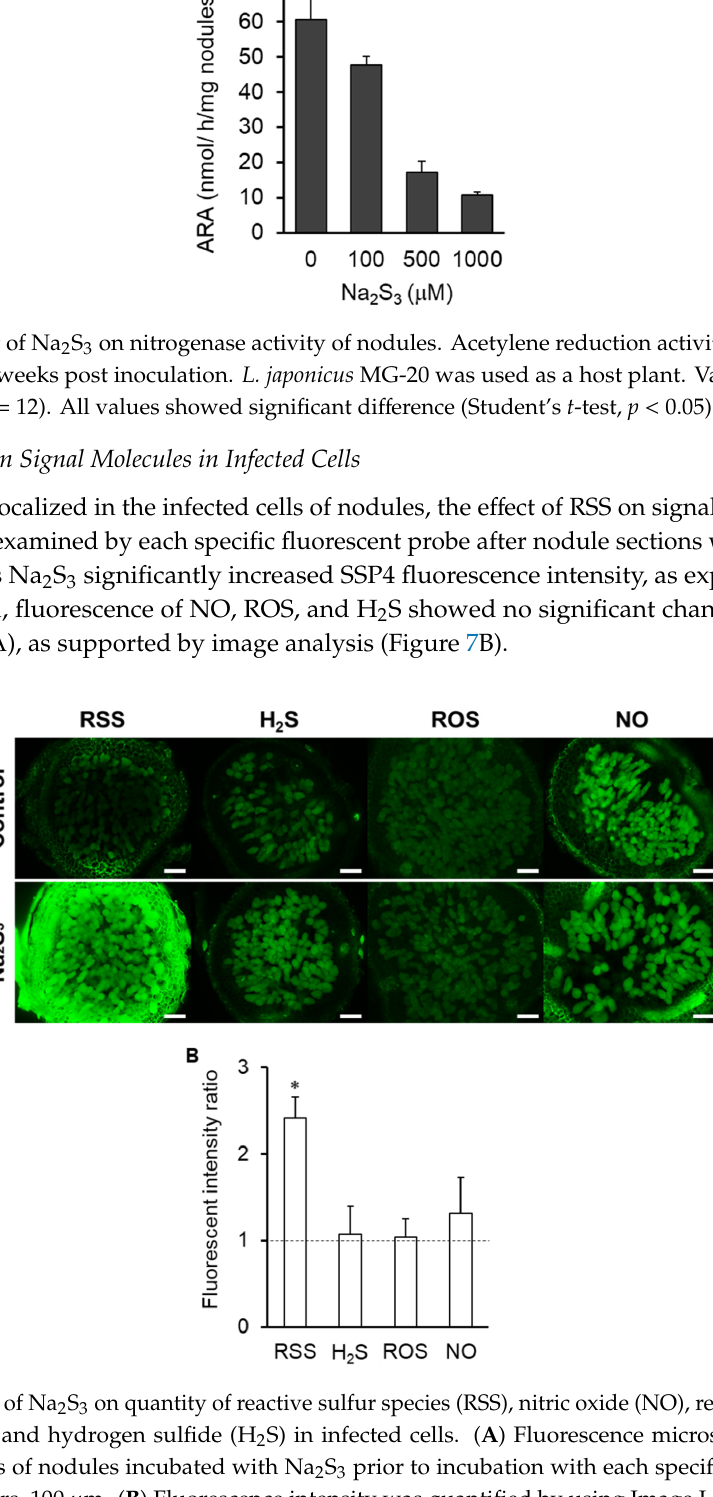
6 of 13 Figure 4. Detection of reactive sulfur species in nodules. Blue fluorescence indicates nodule cell walls stained with calcofluor white. Green fluorescence indicates RSS labeled with SSP4. The green fluorescence of without SSP4 shows autofluorescence. L. japonicus B-129 was used as a host plant. Scale bars, 100 μ m. 3.4. Effect of RSS on Rhizobial Infection Na 2 S 3 was applied to L. japonicus seedlings, and the number of ITs was counted at 10 days after inoculation of M. loti . ITs were counted in two groups (incipient and long ITs) according to the terminology of Ma ł olepszy et al. [58], except that in our case the elongating ITs were also considered as long ITs. The total number of ITs was significantly higher in roots treated with the donor than in control roots (Figure 5A). The number of long ITs was significantly higher in roots treated with the donor than in control roots, although no difference was observed in the number of incipient ITs (Figure 5B). At 1 month after inoculation, the number and fresh weight of nodules on roots treated with the donor was significantly higher than on control roots (Figure 5C,D). Figure 5. Effect of Na 2 S 3 on infection threads (ITs) and nodules. Na 2 S 3 was added every 72 h during the first 10 days after inoculation of Mesorhizobium loti . ( A ) Total number of ITs. ( B ) Numbers of long or incipient ITs counted at 10 dpi. ( C ) Nodule number and ( D ) nodule fresh weight (mg) per plant were measured at 1 month post inoculation (mpi). L. japonicus B-129 was used as a host plant. Values are shown as means ± SE; n = 24 for number of infection threads and n = 18 for number and fresh weight of nodules. Asterisks denote statistically significant differences compared to controls (Student’s t -test, * p < 0.05). 3.5. Effects of RSS on Nitrogenase Activity of Nodules